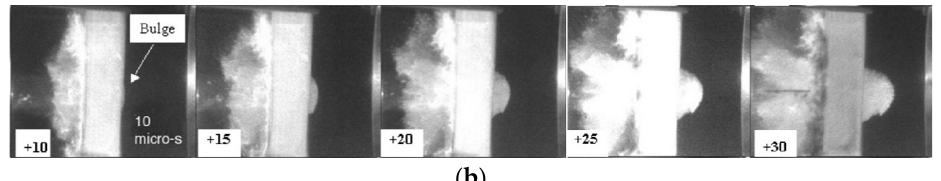
Figure 15. Impact process simulated by SPH method with the present contact algorithm and observed by experiment [30]: ( a ) SPH simulation; ( b ) Experiment.